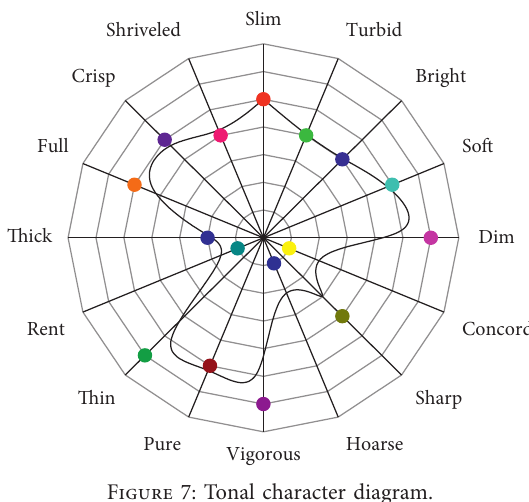
Figure 7: Tonal character diagram.